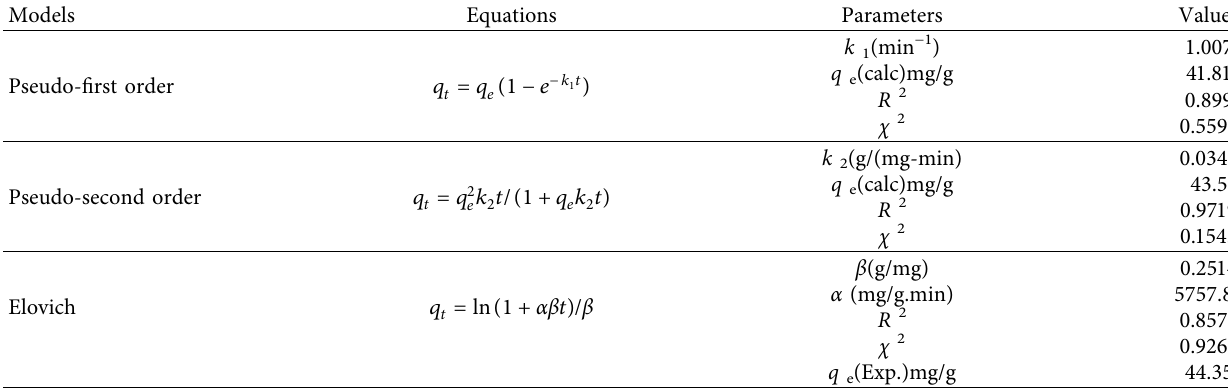
Table 5: Kinetic parameters and their correlation coefficients calculated for the adsorption of MB by UV/n-GO (pH � 6; dosage � 0.4g/L; concentration � 25mg/L; temperature �